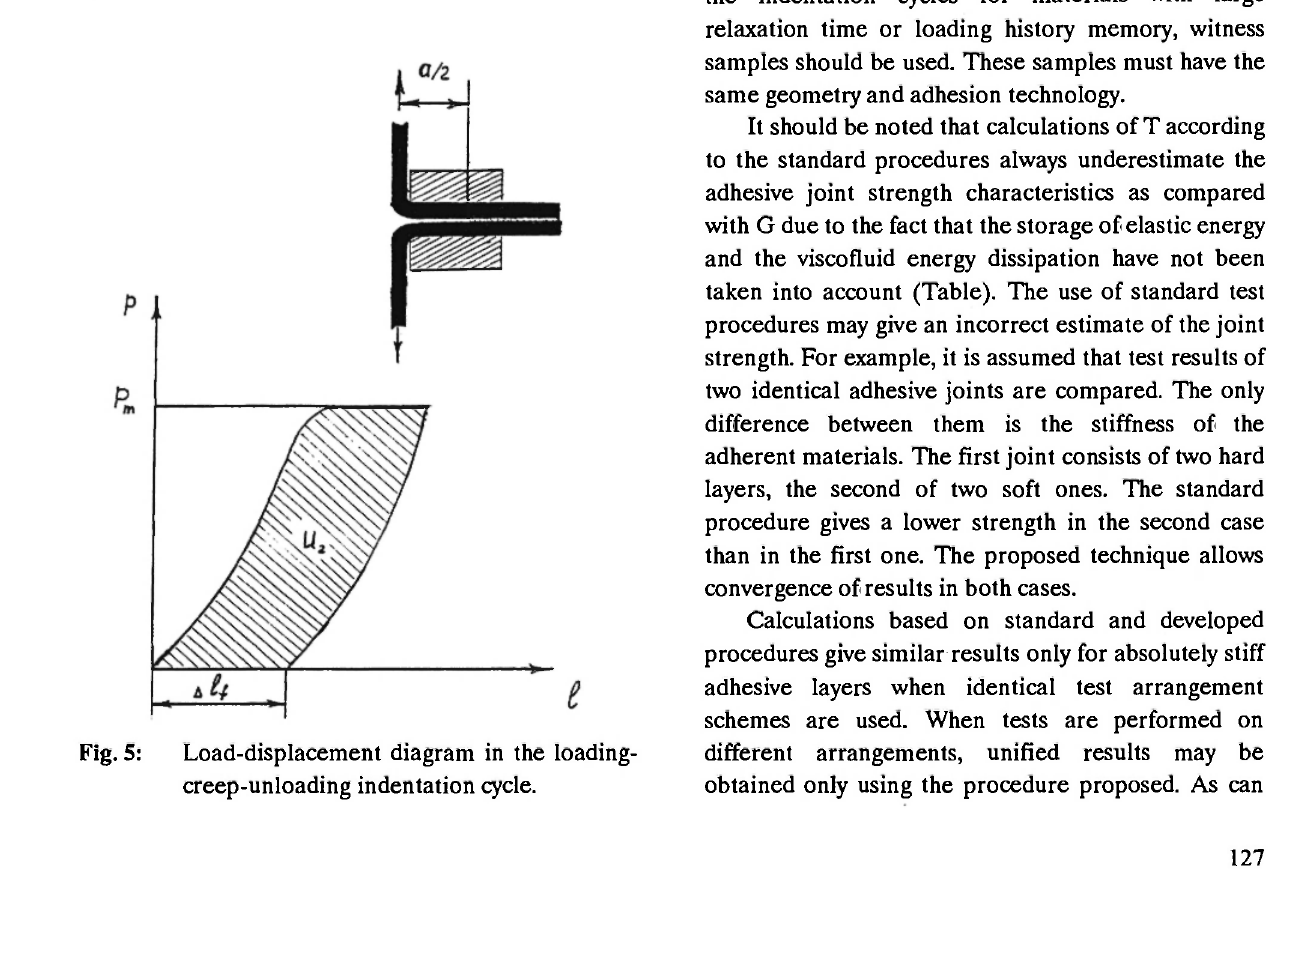
Fig. 5: Load-displacement diagram in the loading- creep-unloading indentation